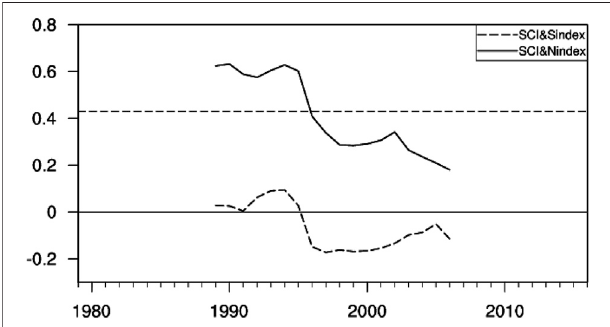
FIGURE 2 | The 21-years sliding correlation between the ONDJ TP SCI and the Nindex (solid line) and Sindex (dashed line) of EAWM. The years are labeled based on the central year of the 21-years window. The horizontal dashed lines indicate correlation coef fi cient the 95% con fi dence level.